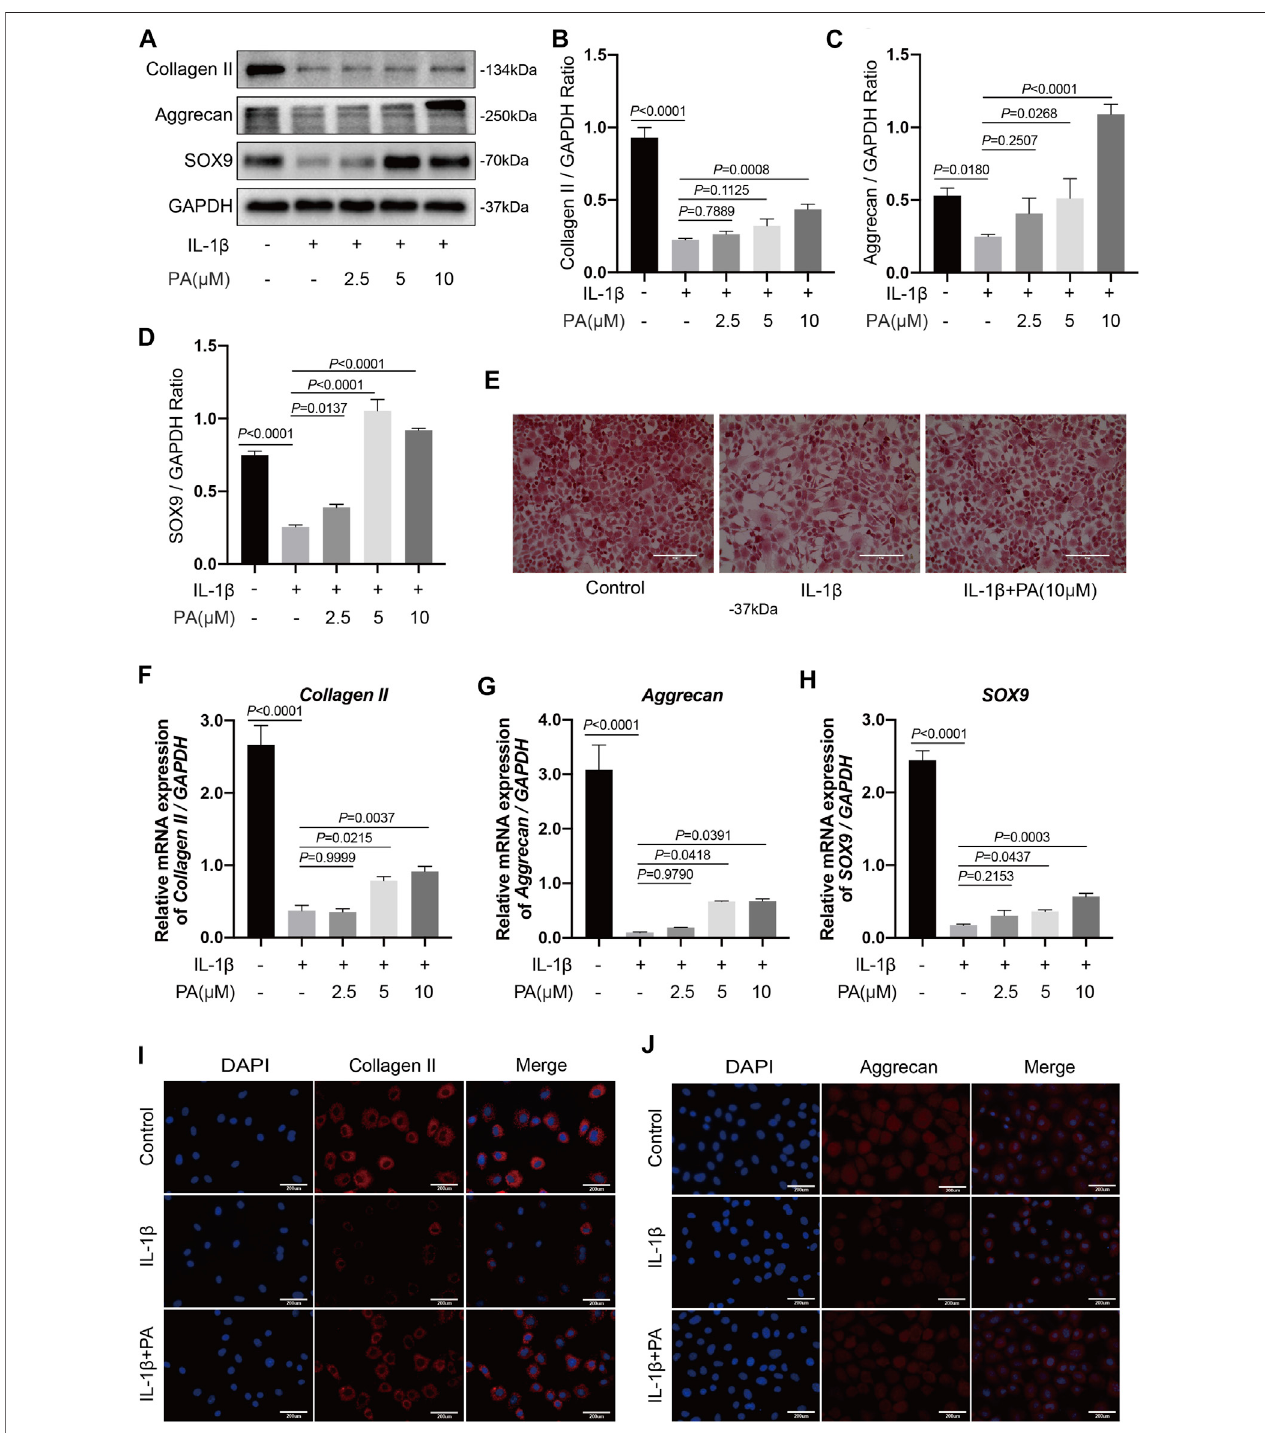
FIGURE 4 | PA upregulated anabolic indicators including collagen II, aggrecan, and SOX9 expression in IL-1 β -induced chondrocytes. (A) Western blotting results and (B – D) quantitative analysisof collagen II, aggrecan, and SOX9. (E) Safranin O stainingre fl ected the content ofproteoglycan among the control, IL-1 β (5 ng/ml),and IL-1 β (5 ng/ml)+PA(10 μ M)groups(scalebar200 μ m). (F – H) RelativemRNAlevelsofcollagenII,aggrecan,andSOX9inchondrocytesstimulatedwith5 ng/mlofIL-1 β , aloneorwithPA(2.5,5,and10 μ M)for24 h.GAPDHwasusedasaninternalreference.Dataarepresentedasmeans ± SD( n (cid:1) 3).Theexact p valuewasmarkedin thecorresponding fi gureand p < 0.05wasconsideredstatisticallysigni fi cant. (I,J) CollagenIIandaggrecanexpressionobservedbyimmuno fl uorescencestainingwhen chondrocytes were treated with 5 ng/ml of IL-1 β , alone or with 10 μ M of PA (scale bar 200 μ m).